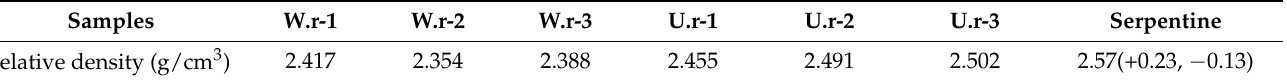
Table 1. The relative densities of weathering rinds and unweathered cores.